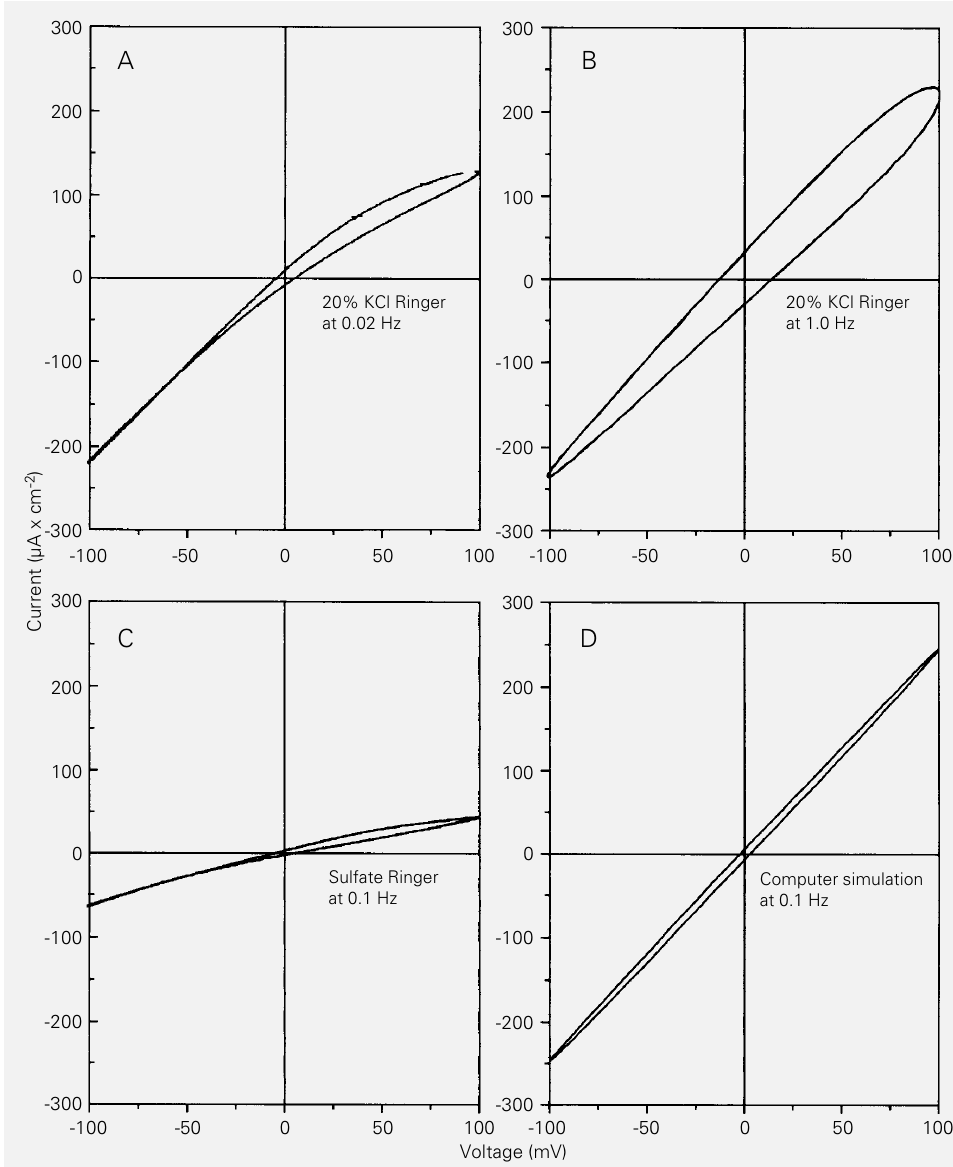
Figure 7 - Response to sinusoi- dal voltages under other condi- tions. A , I vs V relation with sinu- soidal stimulation at 0.02 Hz and 20% Cl - Ringer. B , Same proto- col as in A , but stimulation at 1.0 Hz. C , I vs V relation with 0.1 Hz sinusoidal stimulation in pure sulfate (absence of Cl - )